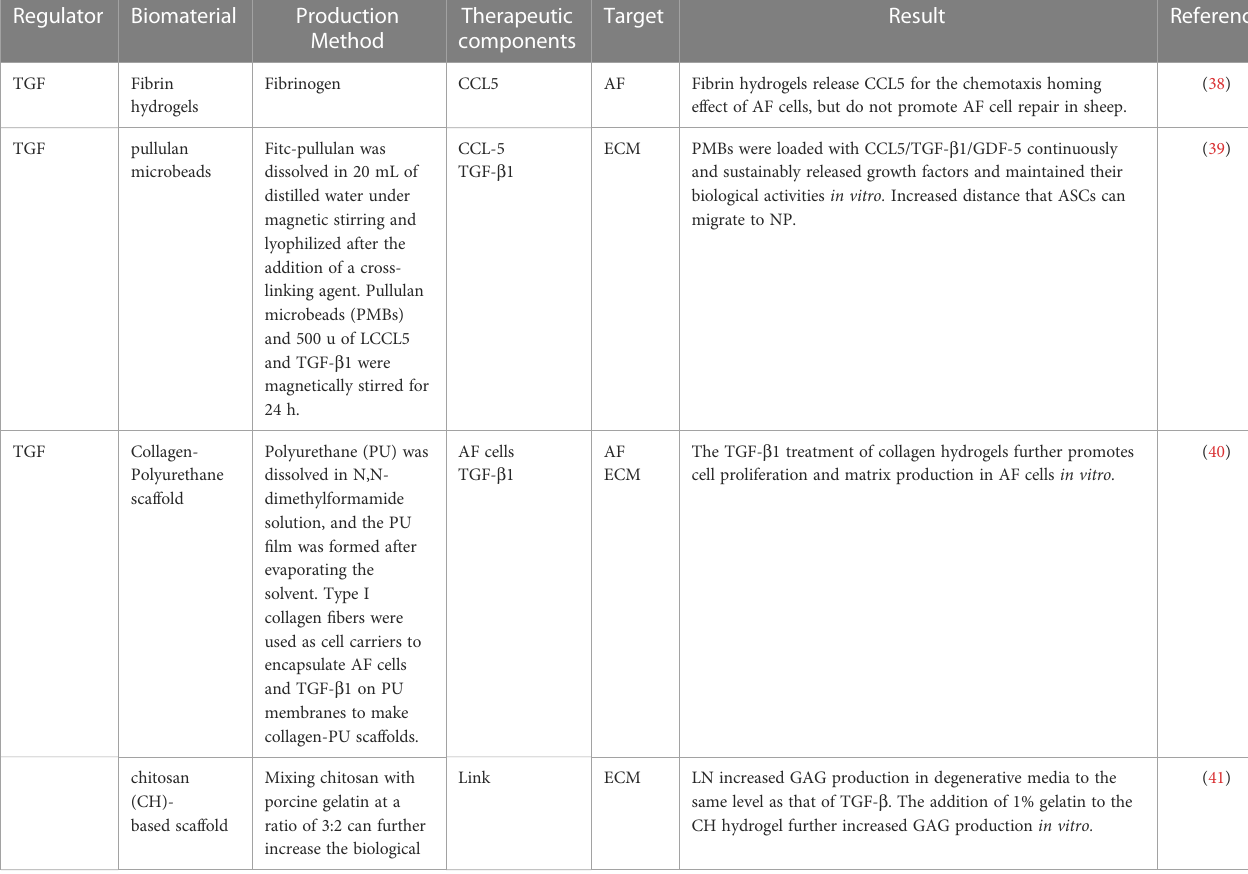
TABLE 1 Biomaterials regulate the in fl ammatory microenvironment to repair degenerated intervertebral discs. Regulator